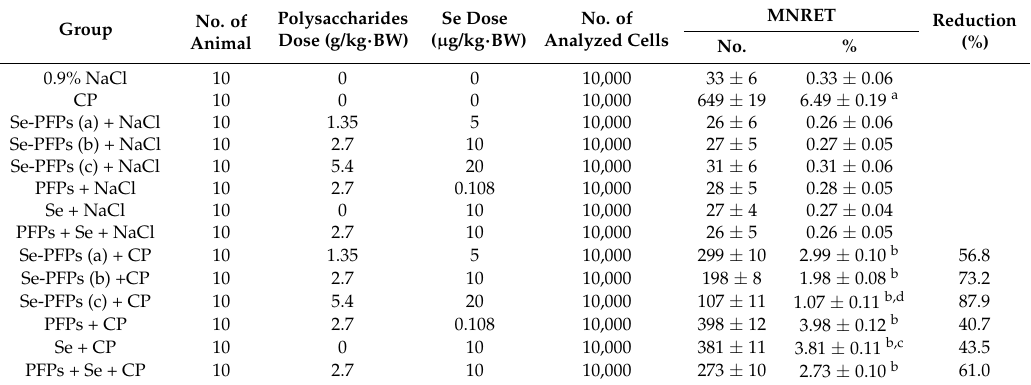
Table 3. Frequencies of micronucleated reticulocytes (MNRETs) in peripheral blood of mice after various